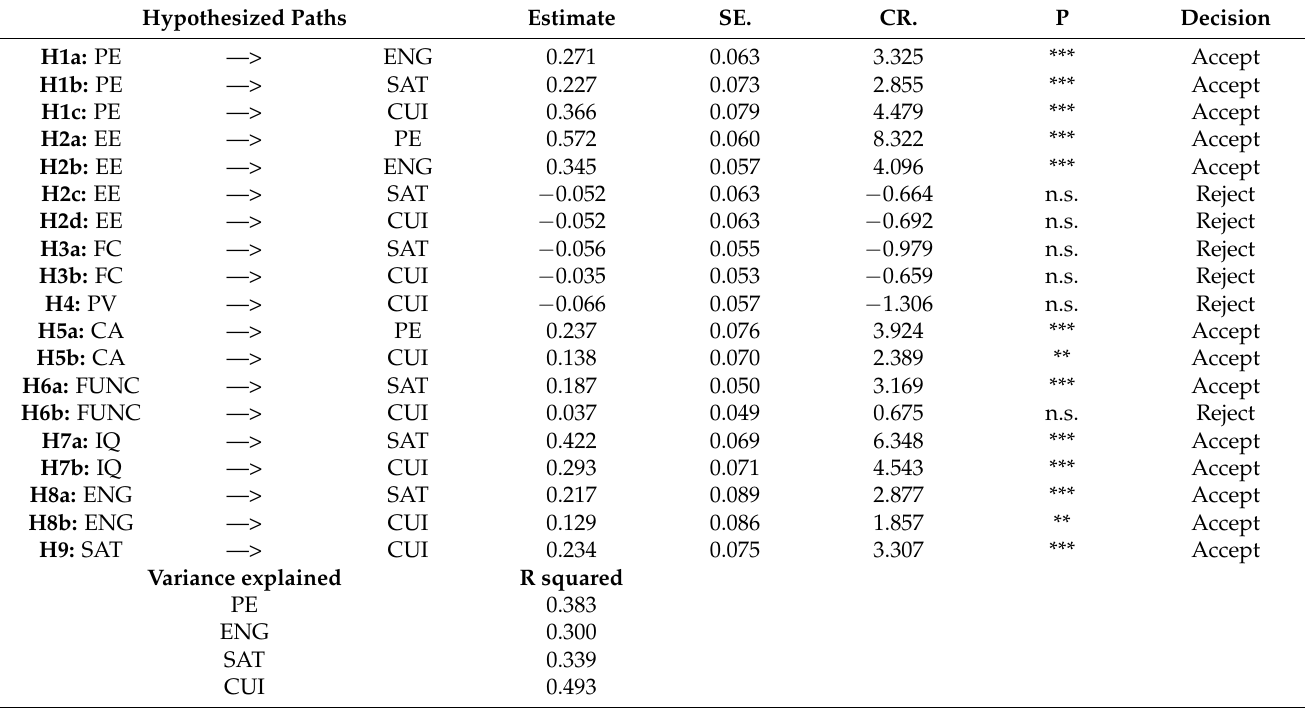
Table 6. Hypothesis results. Hypothesized Paths